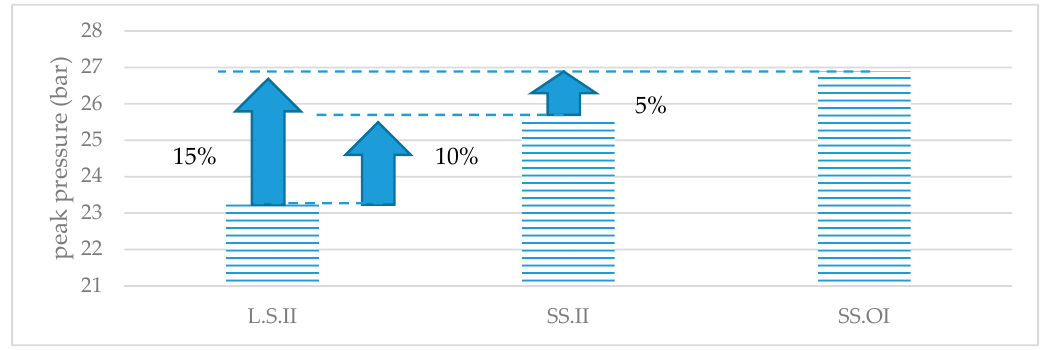
Figure 13. Optimization of intake port shape and sealing length.